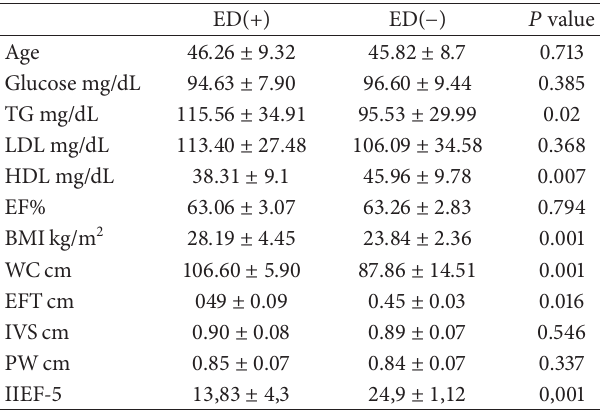
Table 1: Basal characteristic of